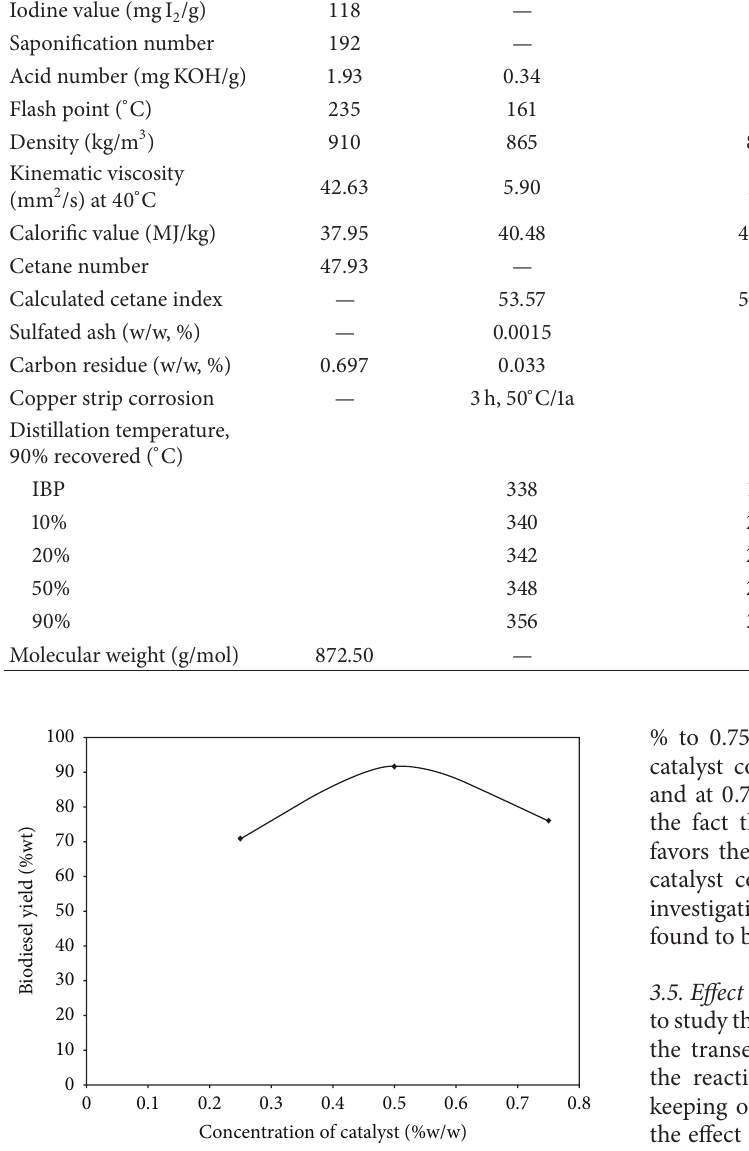
Figure 3: Effect of catalyst concentration on biodiesel yield (molar ratio of 6 :1, reaction temperature of 60 ∘ C, and reaction time of 60